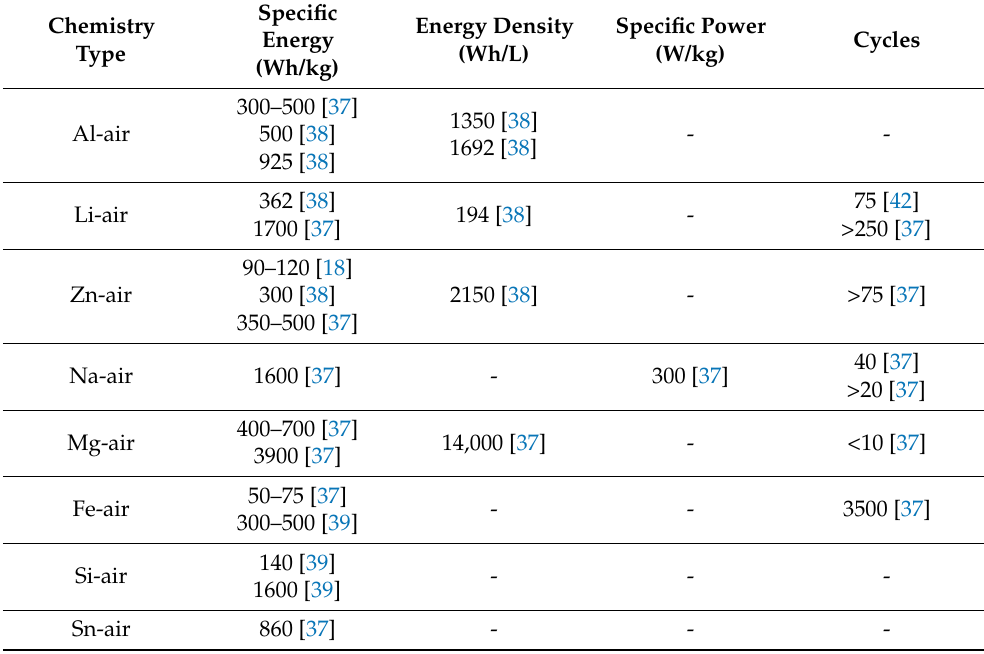
Table 3. Selection of most common metal–air chemistry